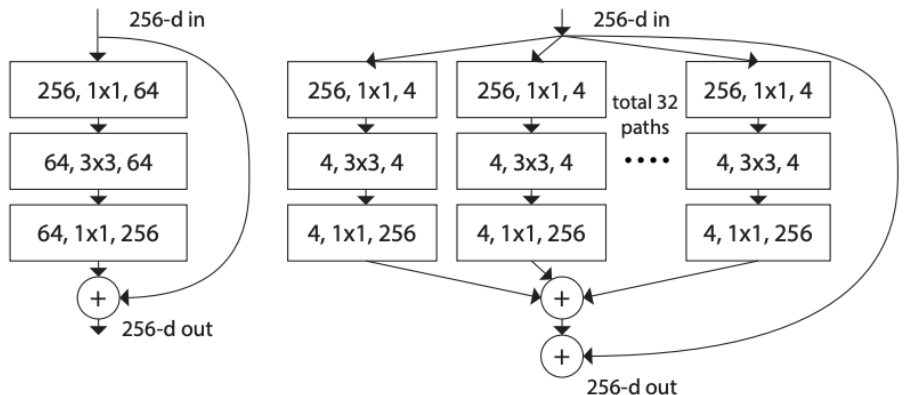
Figure 8. ResNet and ResNeXt blocks [33].